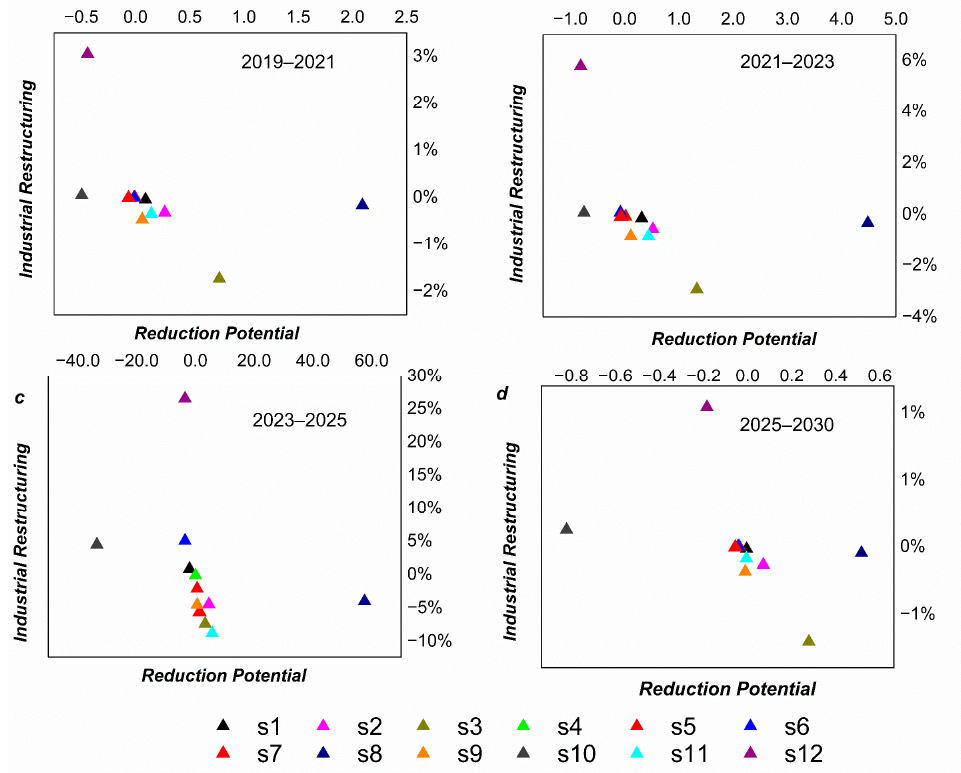
Figure 5. Industrial structure change of S1-S12 sectors and their carbon emission reduction potential in Shenzhen from 2019 to 2030.